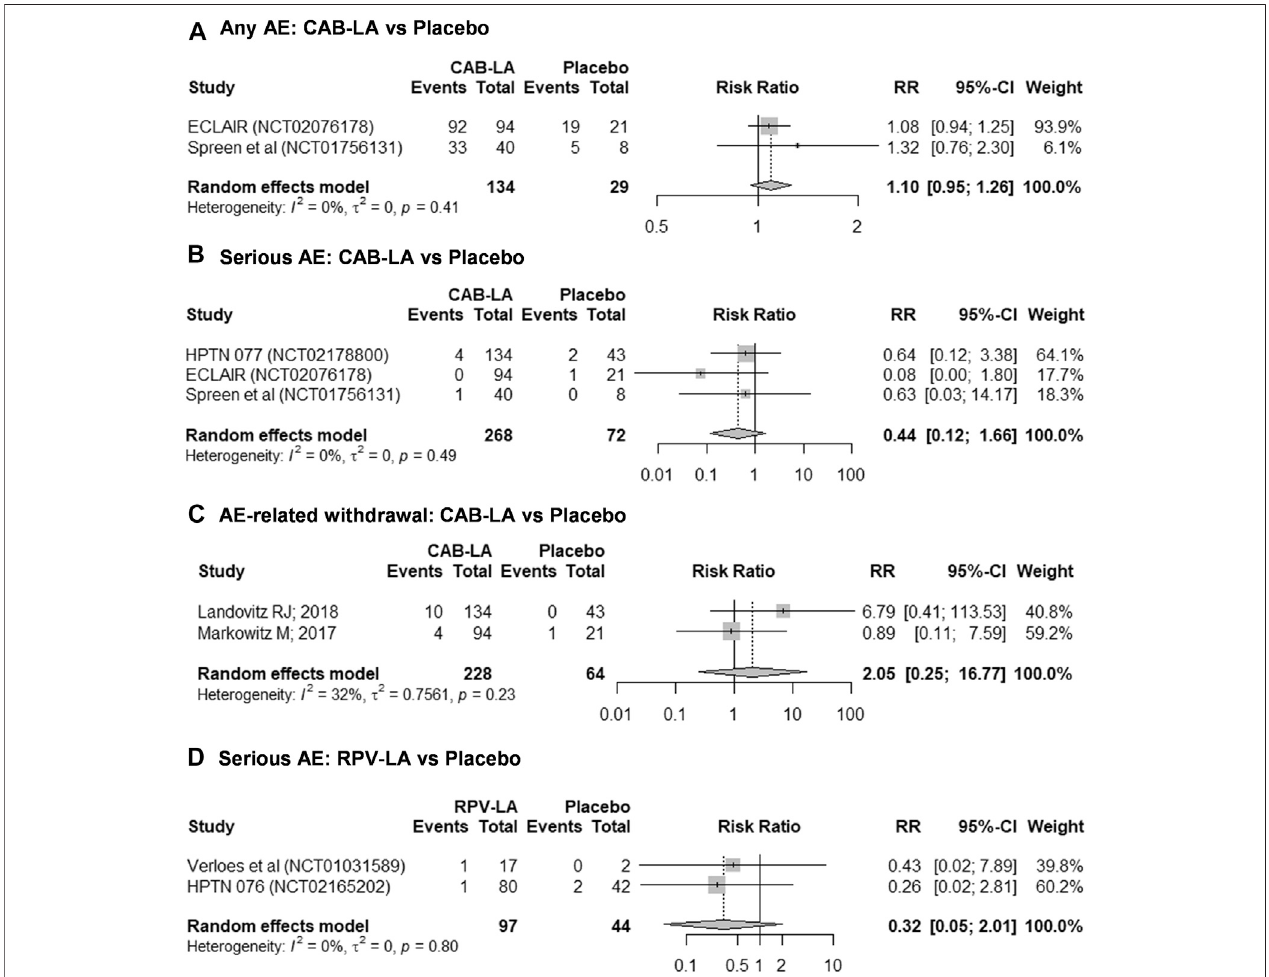
FIGURE2| Meta-analyses on safetypro fi les of (A – C) CAB-LAand (D) RPV-LA: (A) any AE, (B,D) serious AE, (C) AE-relatedwithdrawal. AE,adverse event; CAB- LA, long-acting cabotegravir; RPV-LA, long-acting rilpivirine.